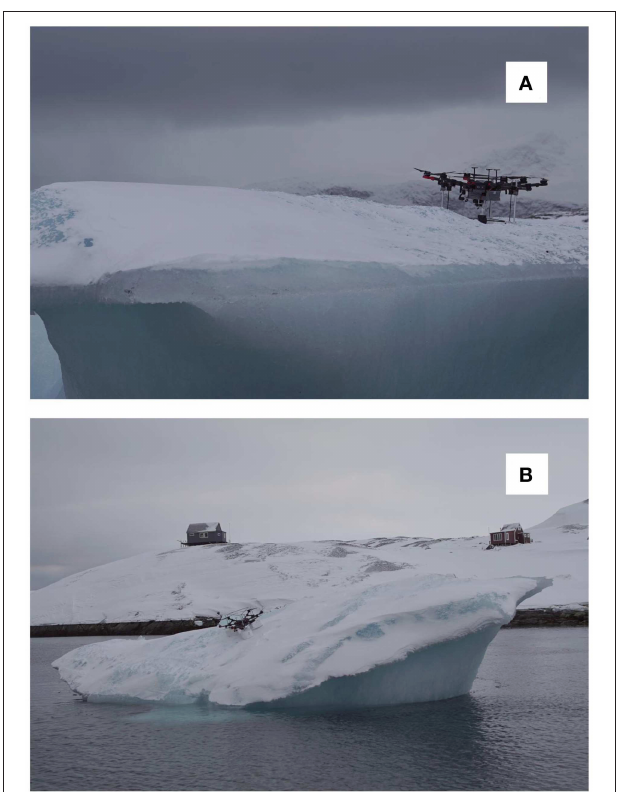
FIGURE 10 | (A) IceDrone drilling on a grounded bergy bit. (B) IceDrone held in place by the drill after the bergy bit rolled.